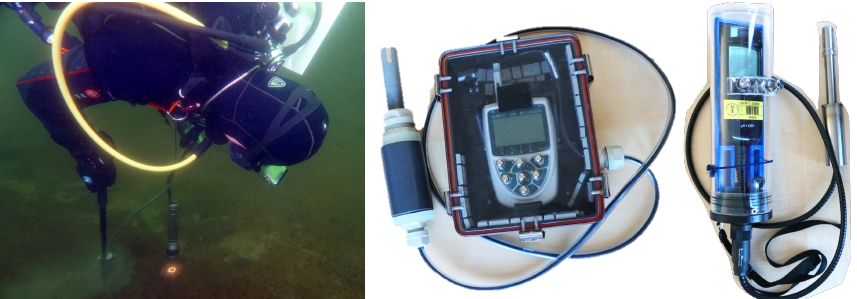
Figure 5. The in situ measurement special lab devices for water parameters, such as electrical conductivity, pH-value, and redox potential are housed for the use of scientific